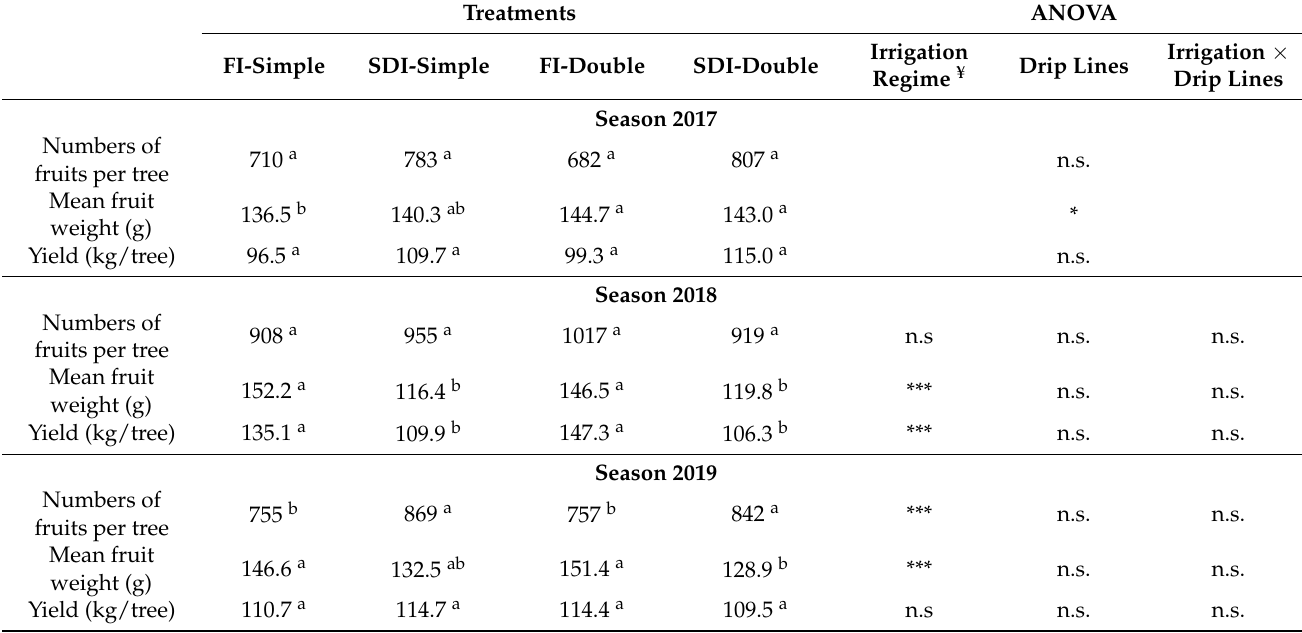
Table 6. Effects of the different irrigation regimes carried out on the lemon trial on yield and its components. The statistical significance for the different factors included in the ANOVA is also included. ***, *, and n.s., mean significant differences at p < 0.001, p < 0.05, and non-significant differences between treatments, respectively. Within each row, different letters indicate significant differences between treatments.